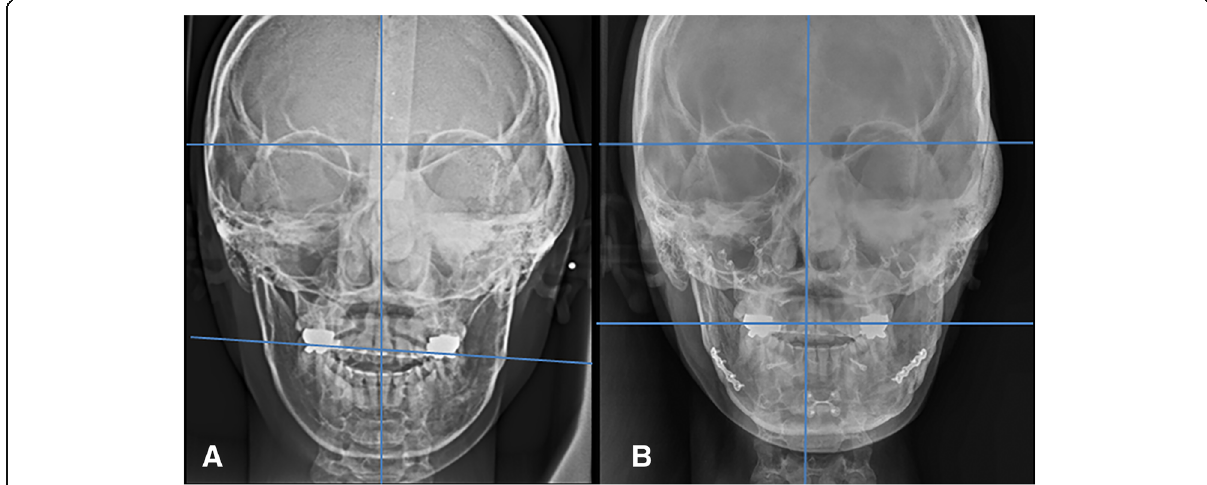
Fig. 3 Preoperative ( a ) and 2 years postoperative radiographic image ( b ) of patient no.